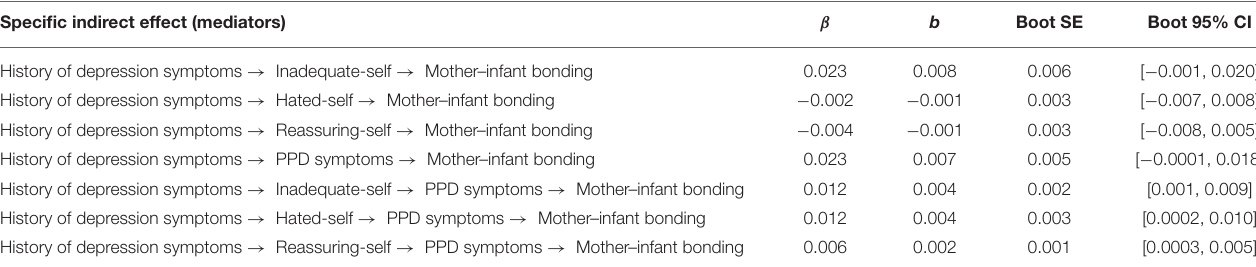
Specific indirect effect